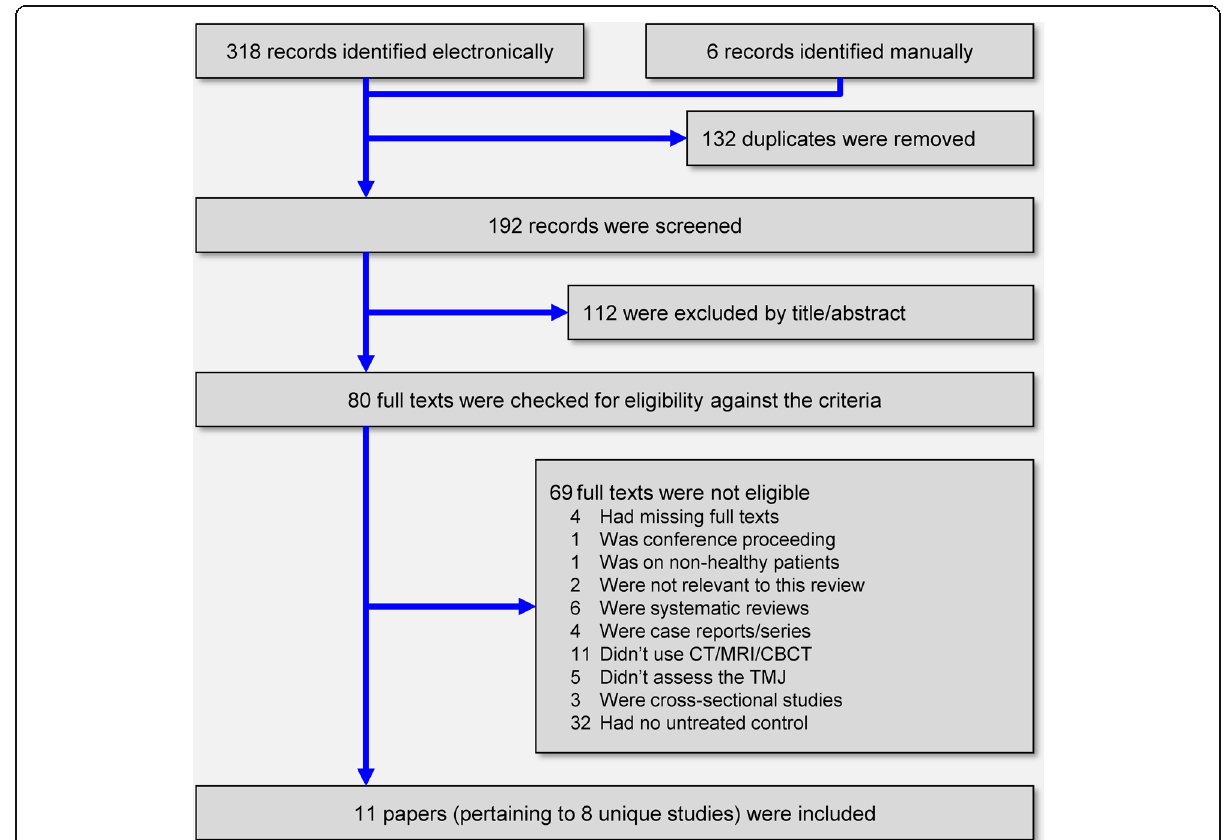
Fig. 1 PRISMA flow diagram for identification and selection of eligible